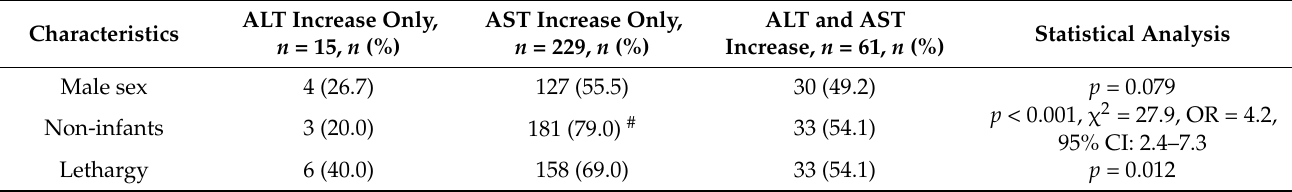
Table 3. Comparative analysis according to transaminase